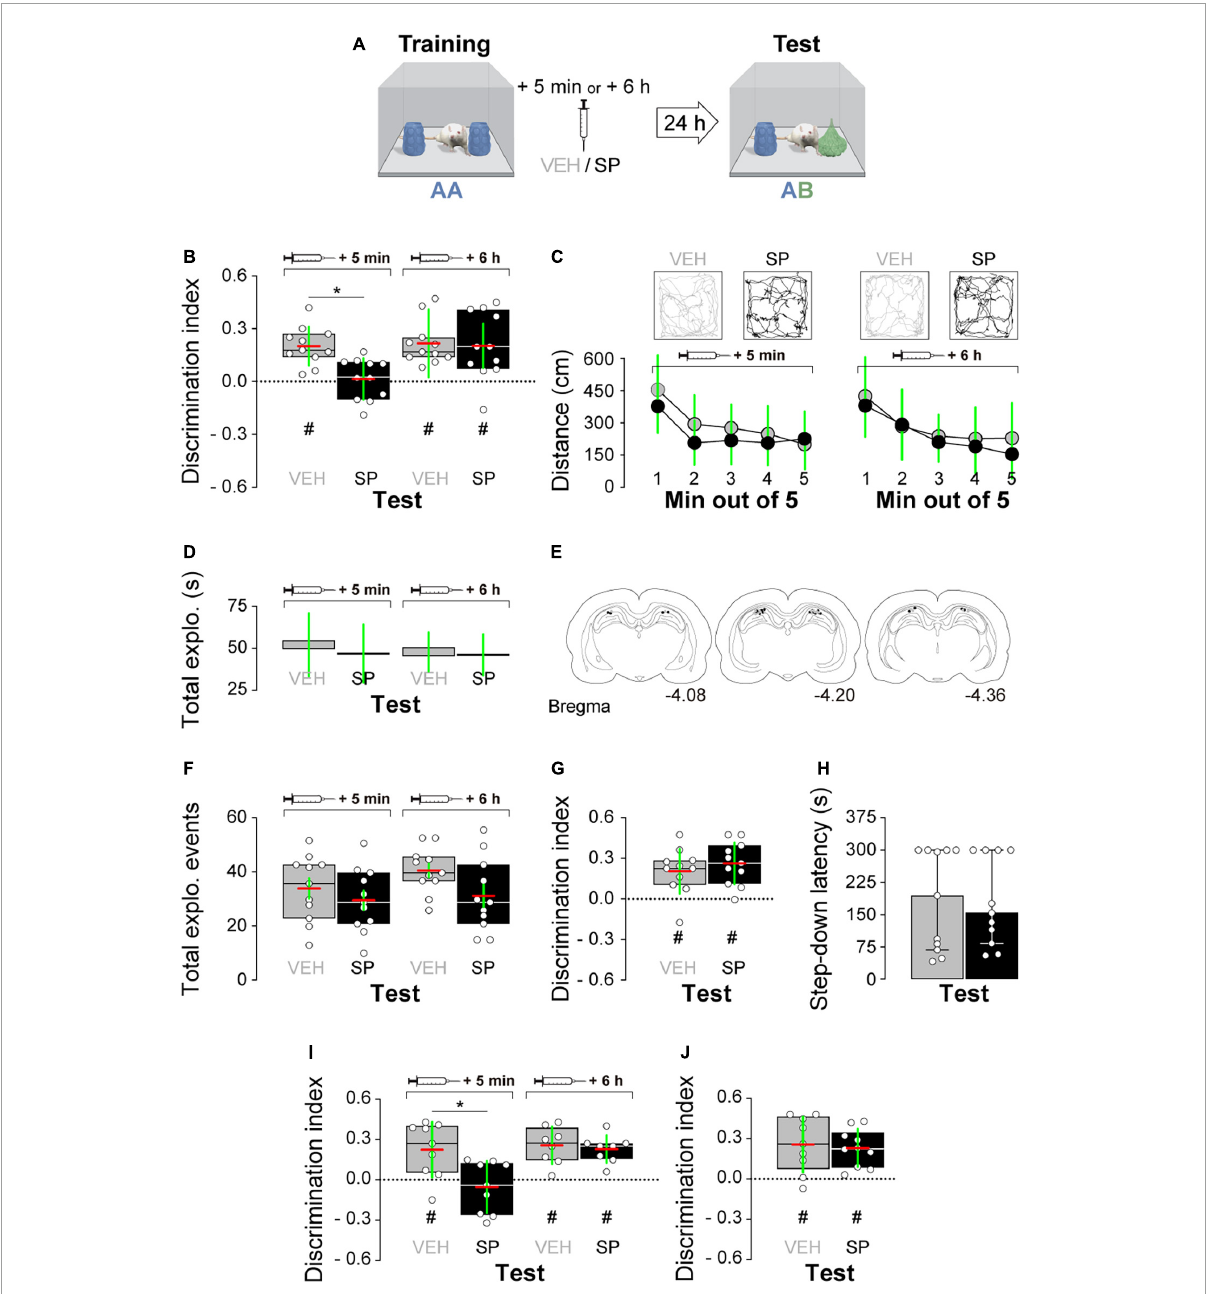
FIGURE1 (A) Experimental protocol. (B) Rats trained in the novel object recognition (NOR) task using two copies of object A received bilateral intra-dorsal CA1 injections of SP600125 (SP; 20 µ M; 1 µ l/side) or vehicle (VEH; 0.1% DMSO in sterile saline) 5 min or 6 h post-training. Object A memory retention was assessed 24 h later (test) in the presence of familiar object A and novel object B. (C , top ) Representative trajectory for VEH and SP-treated animals during Test. (C , bottom ) Mean distance traveled during test for VEH and SP-treated animals. (D) Total object exploration time during Test. (E) Illustration showing cannula placement for animals that received VEH or SP 5 min after training. (F) Number of exploration events during Test. (G) Animals that received SP or VEH 5 min after training were retrained in NOR using a different pair of novel stimuli objects. Object recognition memory (ORM) retention was evaluated 24 h thereafter. (H) Animals that received SP or VEH 5 min after NOR training were trained in the inhibitory avoidance (IA) task. IA memory retention was evaluated 24 h thereafter. (I) Rats were treated as in panel (A) except that the retention test was performed 7 days post-training. (J) Rats were treated as in panel (A) except that the retention test was performed 3 h post-training. Discrimination index (DI) data are expressed as median (black or white horizontal lines) ± interquartile range (boxplots) and as mean (red horizontal line) ± SD (green vertical line). Dashed lines represent chance level. Total object exploration and distance traveled data are presented as mean ± SD. IA data are expressed as median ± interquartile range. n = 8–12 animals per group; # p < 0.05 in one-sample Student’s t -test with theoretical mean = 0; and * p < 0.05 in Bonferroni’s multiple-comparison test after two-way